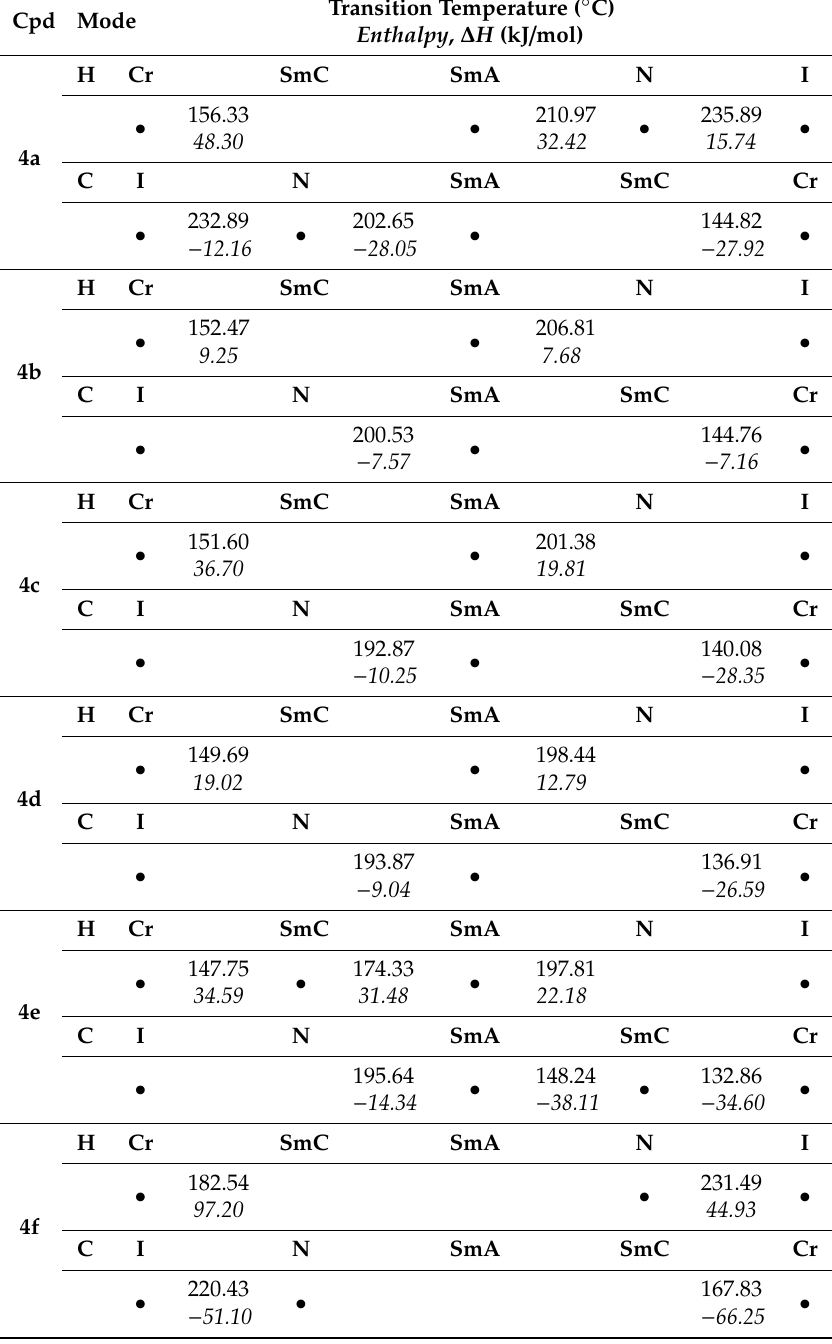
Table 2. Phase transitional properties of compounds 4a – i upon heating and cooling